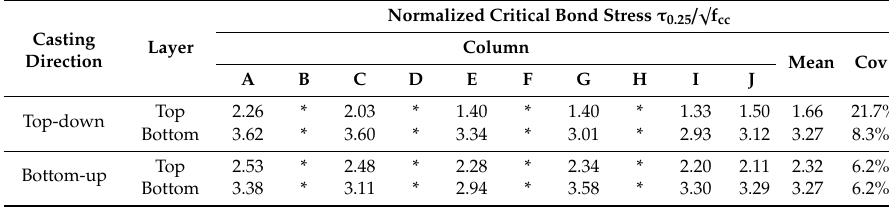
Table 6. Normalized critical bond stress for the rebars in all